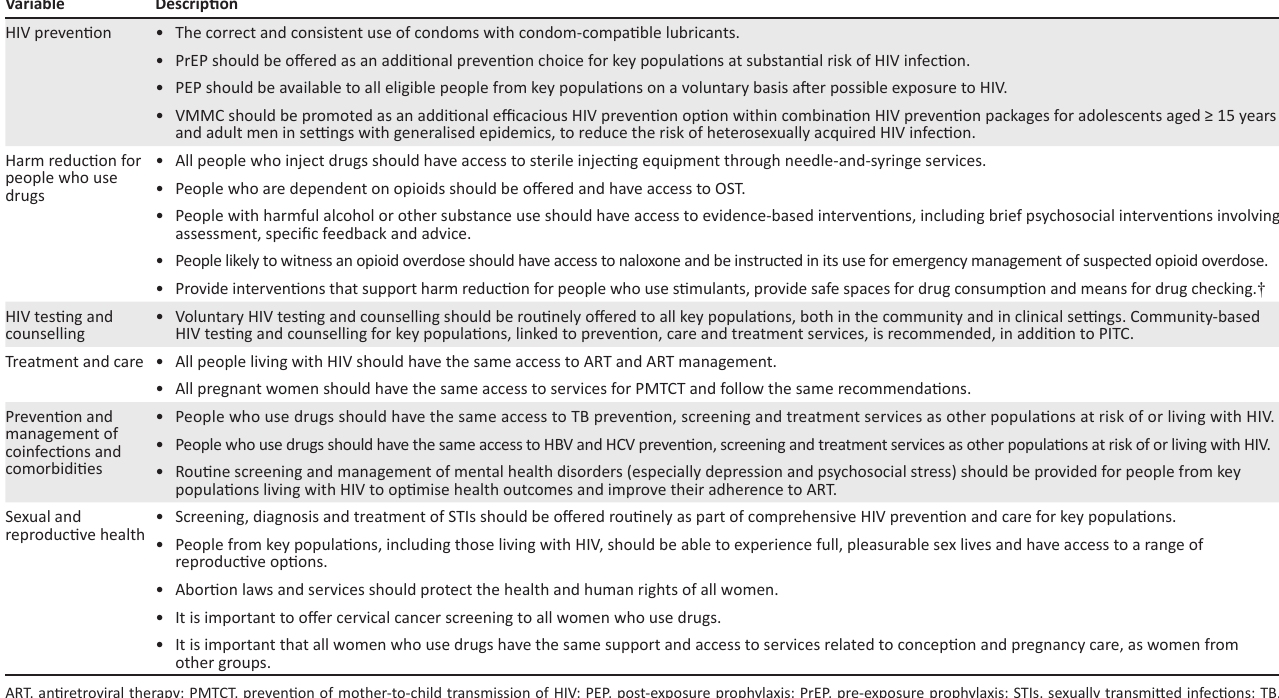
TABLE 7: Health sector interventions. 19